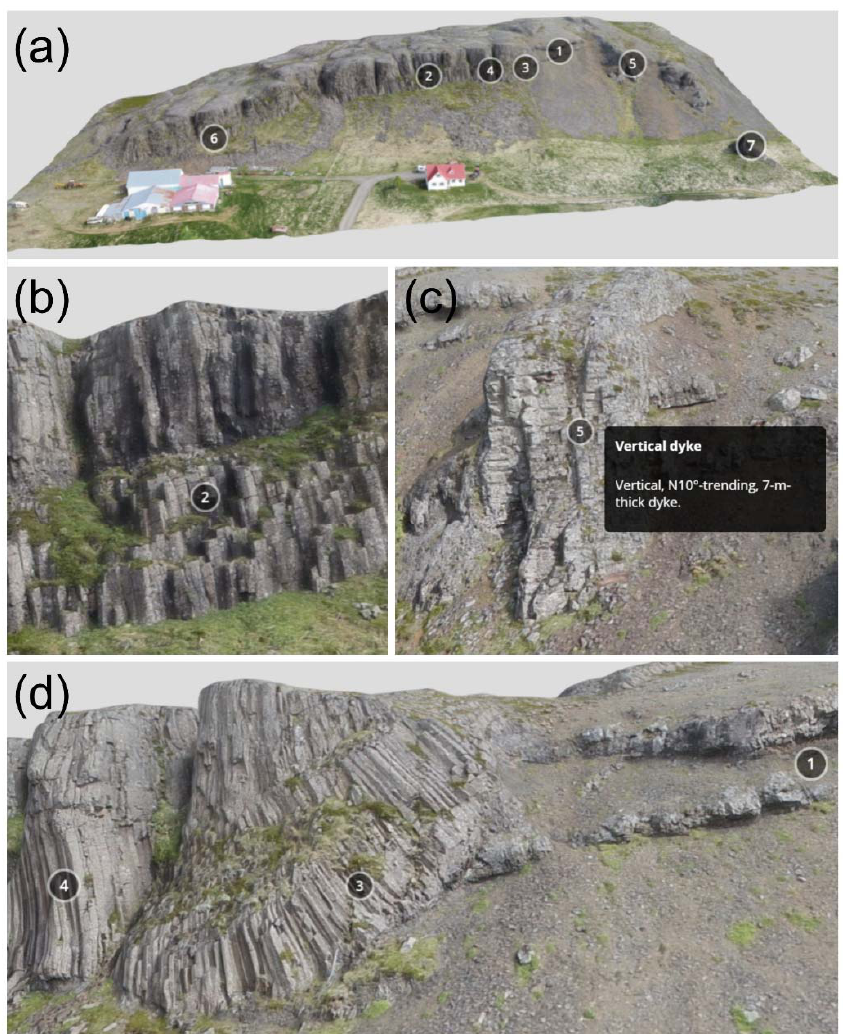
Figure 9. ( a ) Overall view of the 3D model; the group of country houses is for scale. Numbers are interactive annotations that can be clicked online, providing the viewer with explanations about particularly relevant features; ( b ) detail of the laccolith, with the thick columnar joints well visible; ( c ) a 7 m ‐ thick dyke cutting through the lava succession; ( d ) close ‐ up view of the columnar joints that bend to attain a shallower dip.